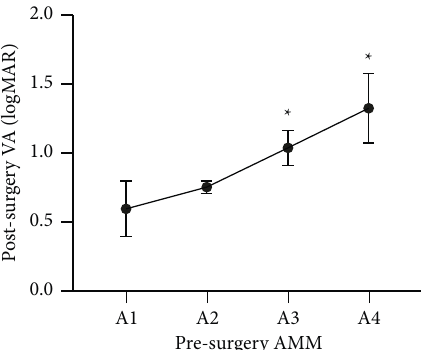
Figure 2: The relationship of presurgery AMM and postsurgery VA (logMAR). It showed a notable increasing trend from A1 to A4 ( P � 0.002, one-way analysis of variance) and significant differences between A3 or A4 and A1 or A2 (P A1-A3 � 0.034, P A2-A3 � 0.007, P A1-A4 � 0.009, and P A2-A4 � 0.006, Fisher’s least significant dif- ference) ( ∗ ). AMM � atrophic myopic maculopathy and VA � vi- sual